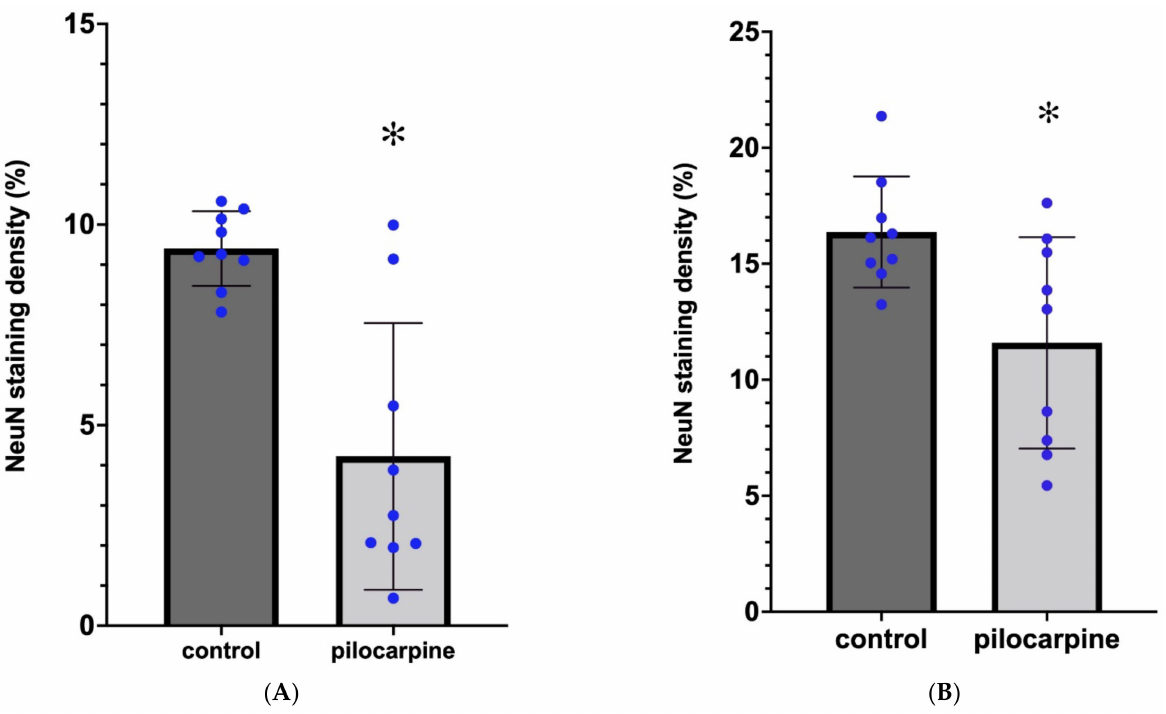
Figure 2. Densitometric analysis of NeuN-stained hippocampi (see Materials and Methods). ( A ) NeuN staining density in the entire Ammon’s horn in control and PT animals (n = 9; paired t -test, * p = 0.0021). ( B ) NeuN staining density in the entire area of the DG in control and PT animals (n = 9; Wilcoxon signed rank test, * p =